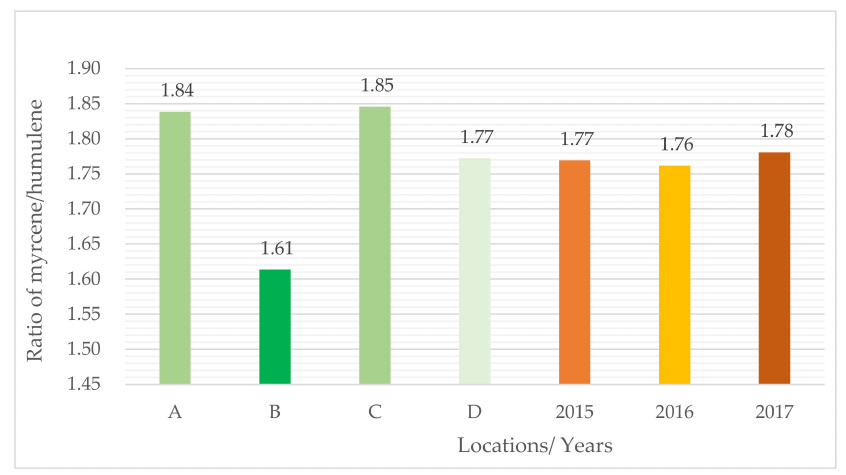
Figure 9. Myrcene to humulene ratio in hop cones depending on localities and years (Mean for